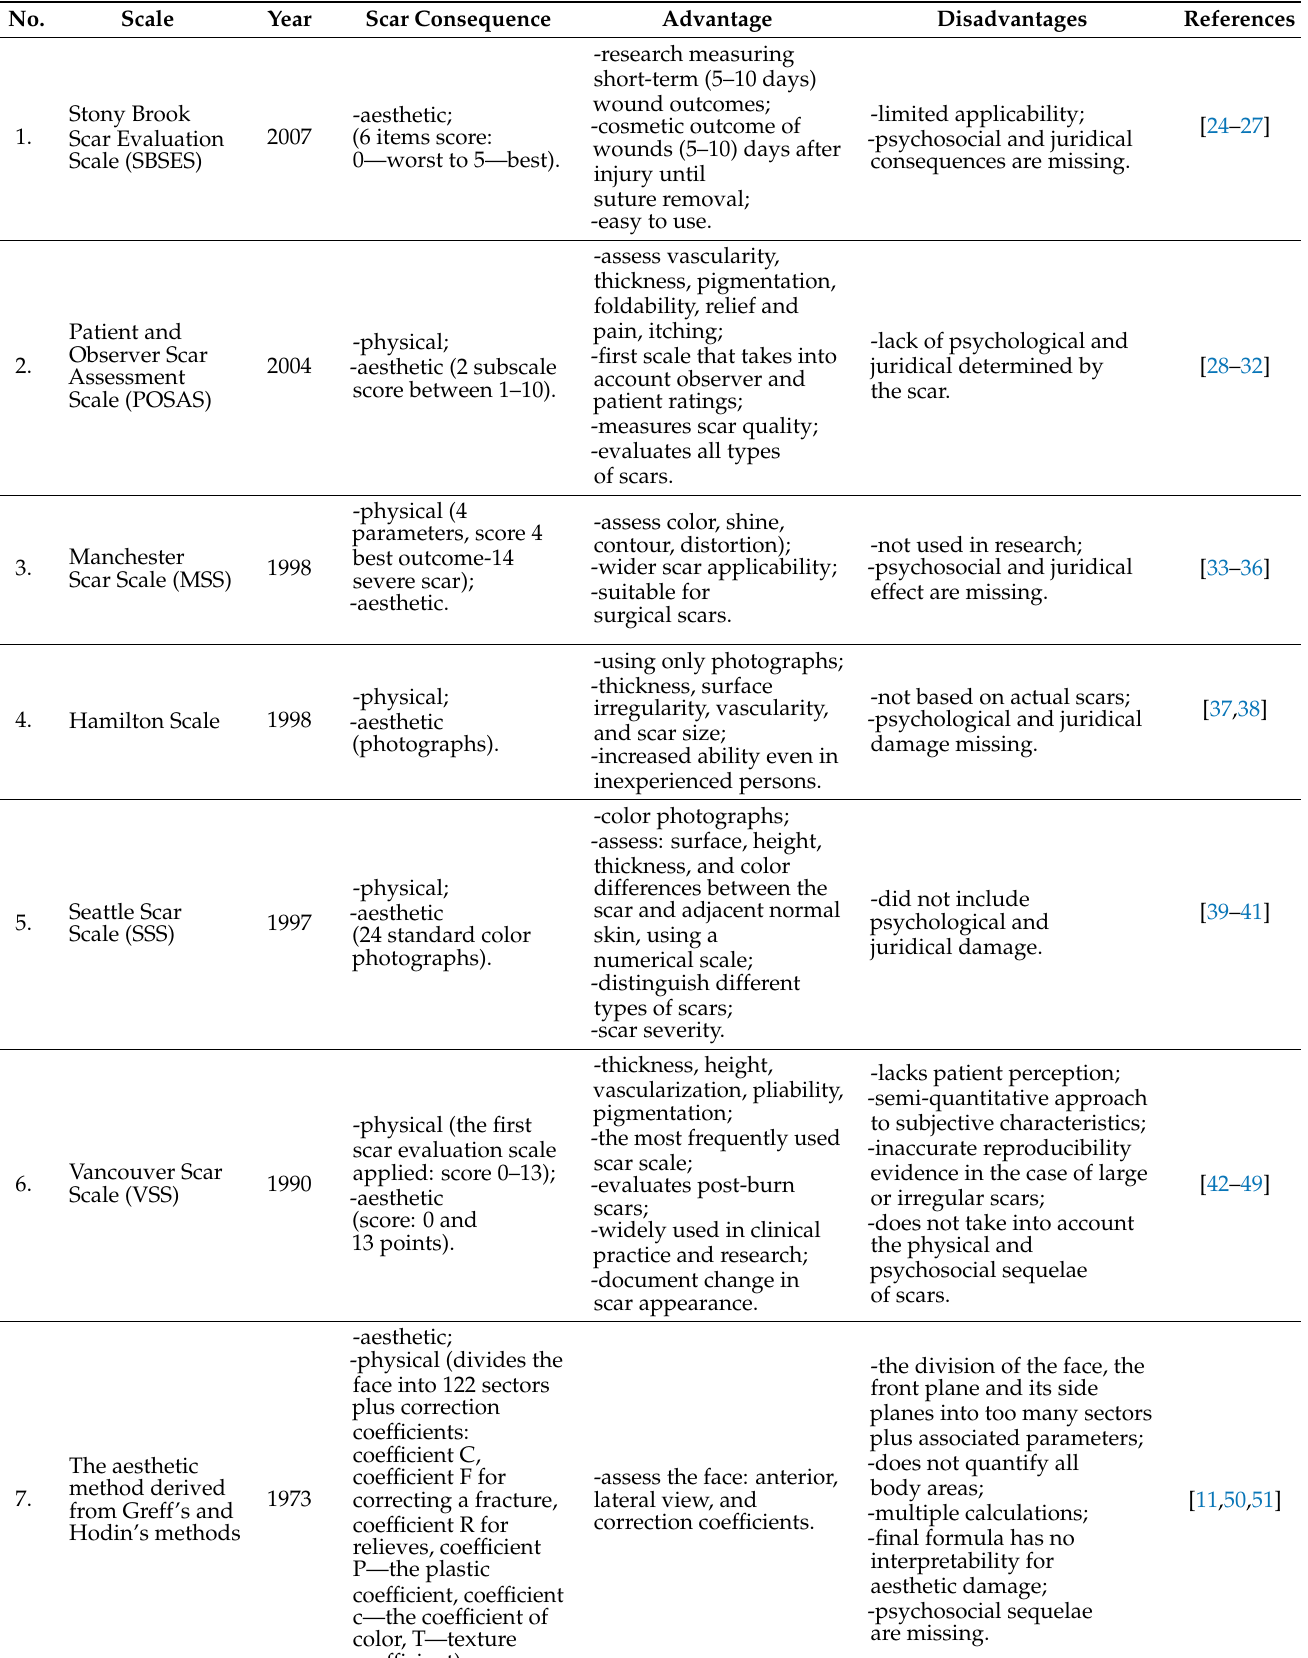
Table 1. Scales for physical assessment of